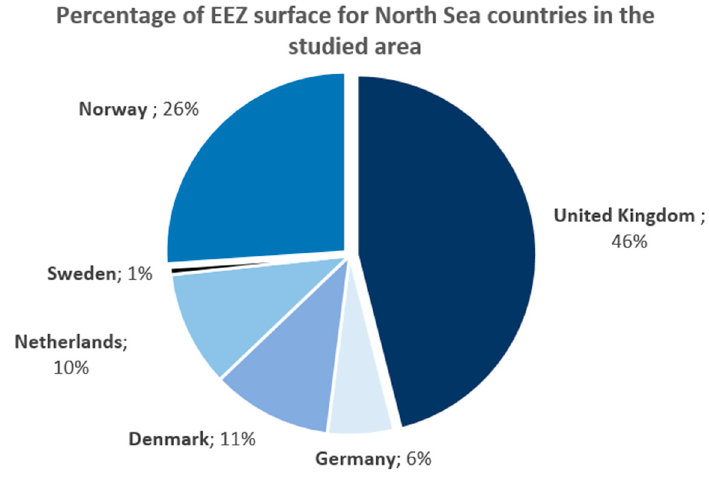
Figure 5. The surface of the Exclusive Economic Zones (EEZ) for the countries in the studied area.